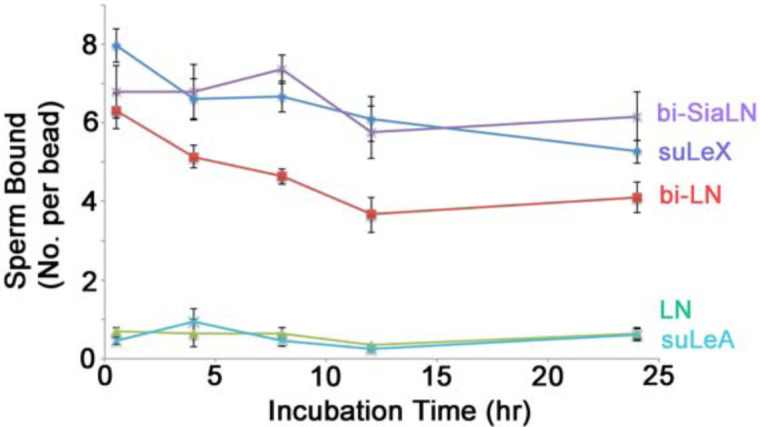
Most sperm remained bound to immobilized oviduct glycans for 24 h.Sperm were incubated with beads coupled with biantennary 6-sialylated N-acetyllactosamine oligosaccharide (bi-SiaLN), biantennary N-acetyllactosamine terminating oligosaccharide (bi-LN), 3-O-sulfated Lewis X trisaccharide (suLeX), 3-O-sulfated Lewis A trisaccharide (suLeA), or N-acetyllactosamine (LN). The number of bound sperm per bead was counted at time points over 24 h. There was a slight decline in the number of bound sperm only in the sperm bound to bi-LN coated beads (P<0.05). Therefore, the number of live sperm bound to the beads was not affected significantly by a release of moribund sperm from the beads.